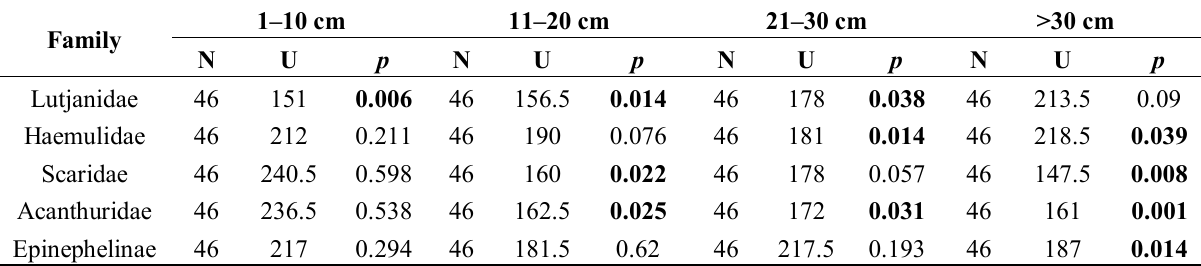
Table 3. Results of post-hoc Mann-Whitney U tests on the five families that demonstrated a significant difference in densities in Kruskal-Wallis tests. Bold p -values indicate significantly higher densities of fishes within MPAs compared to fished reefs in a given size